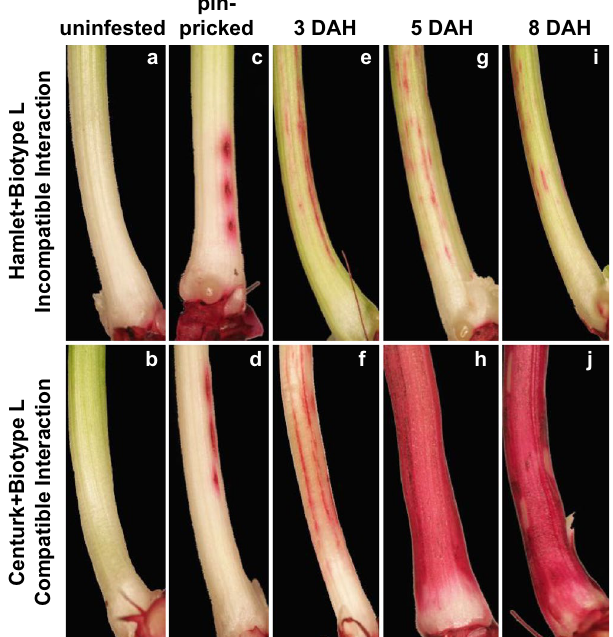
Figure 4. Temporal changes in plant cell wall permeability. Resistant (Hamlet) and susceptible (Centurk) wheat plants stained with neutral red (NR) to assess cell wall permeability at 3 ( e , f ), 5 ( g , h ) and 8 ( i , j ) DAH. Uninfested plants from both wheat lines were stained with NR as negative controls ( a , b ). Some plants from both wheat lines were also pin-pricked ( c , d ) and stained to distinguish staining caused by larval feeding from that caused by physical damage during dissections. Top panels show NR stained Hamlet plants while bottom panels show NR stained Centurk plants. The resistant plants showed limited distribution of NR stain appearing as blush, spots, broken lines and solid lines. The susceptible plants showed intense staining as dark streaks and lines covering the entire length of the crown